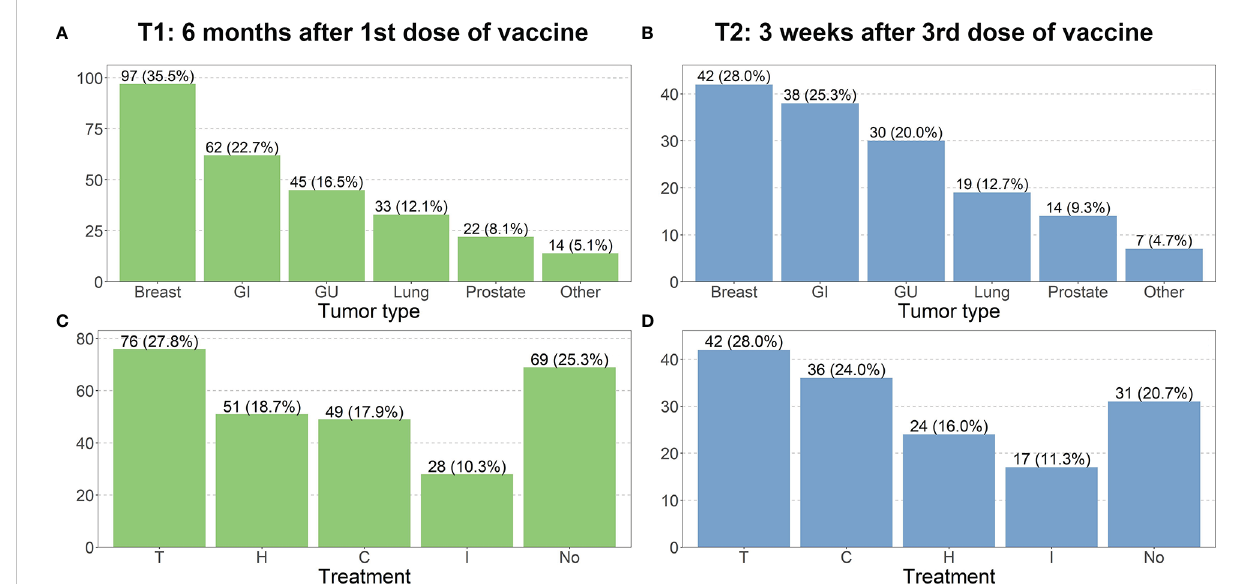
FIGURE 1 Distribution of tumor type and treatment at different time point. Charts ( A – D ) refer respectively to T1 and T2. (GI, Gastrointestinal; GU, Genitourinary; C, Chemotherapy; H, Hormone therapy; I, Immunotherapy; T, Target therapy; No, No